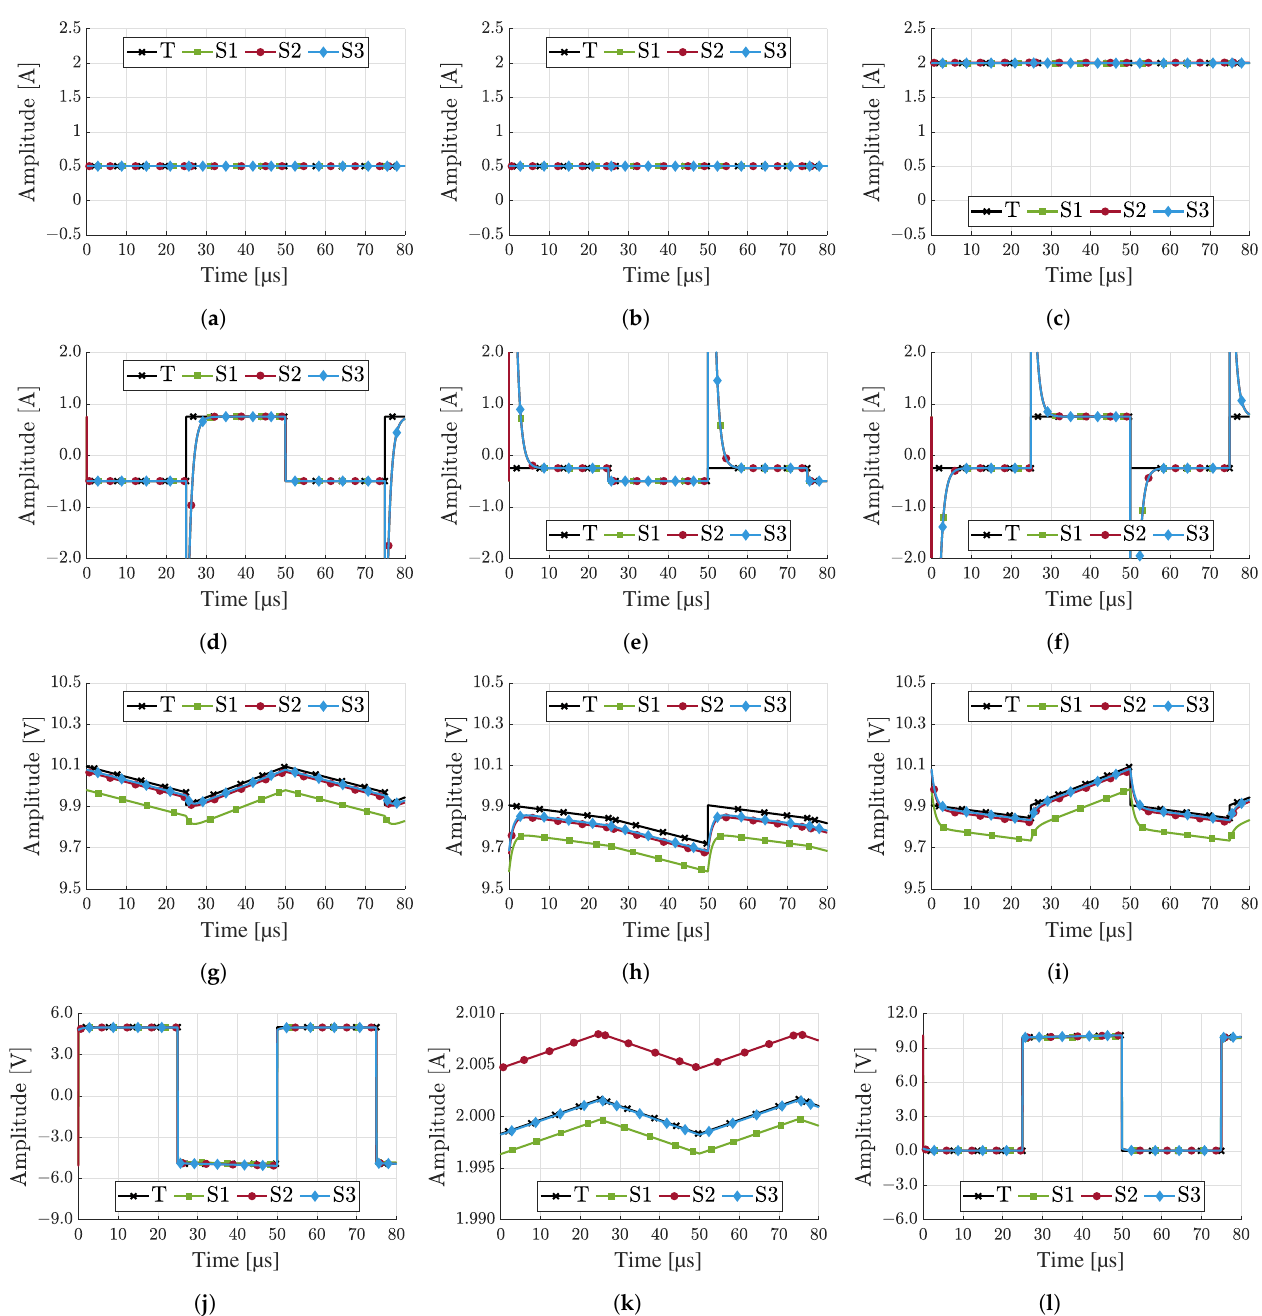
( t ) with small ripple approxima- B ( t ) ; ( k ) i ( t ) without small ripple approximation. L B B